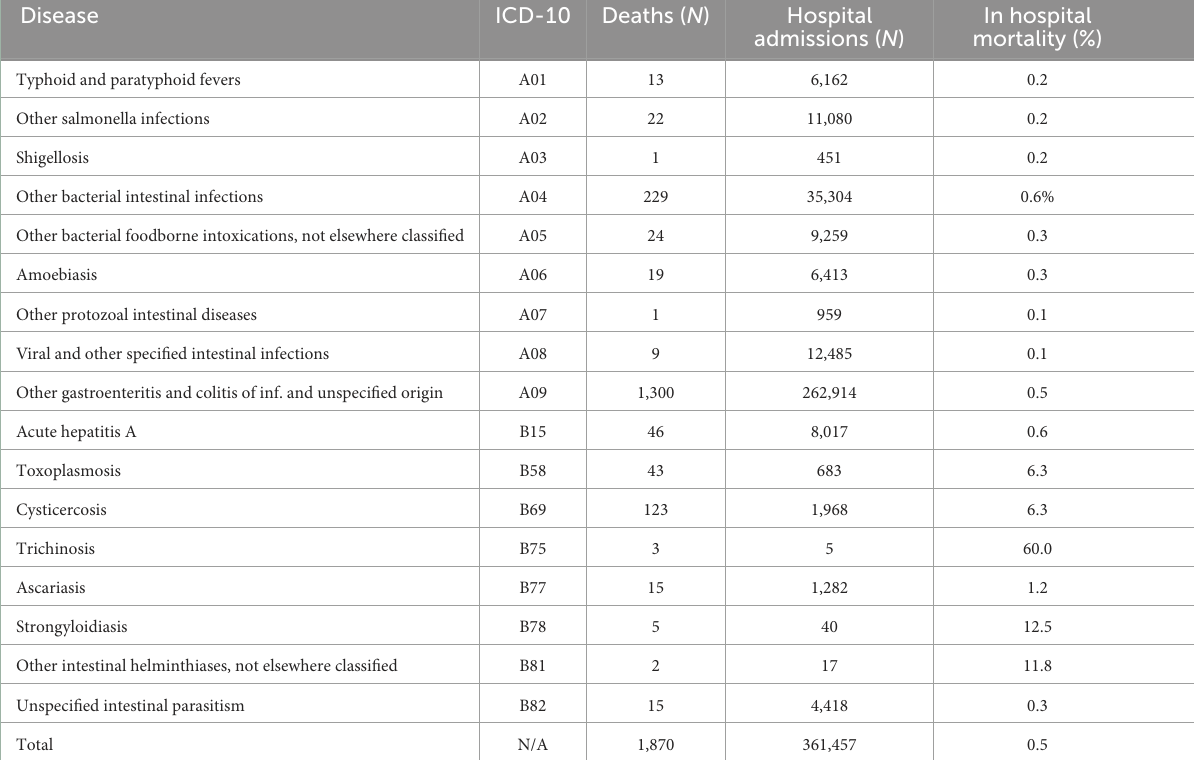
In hospital admissions ( N ) mortality (%)